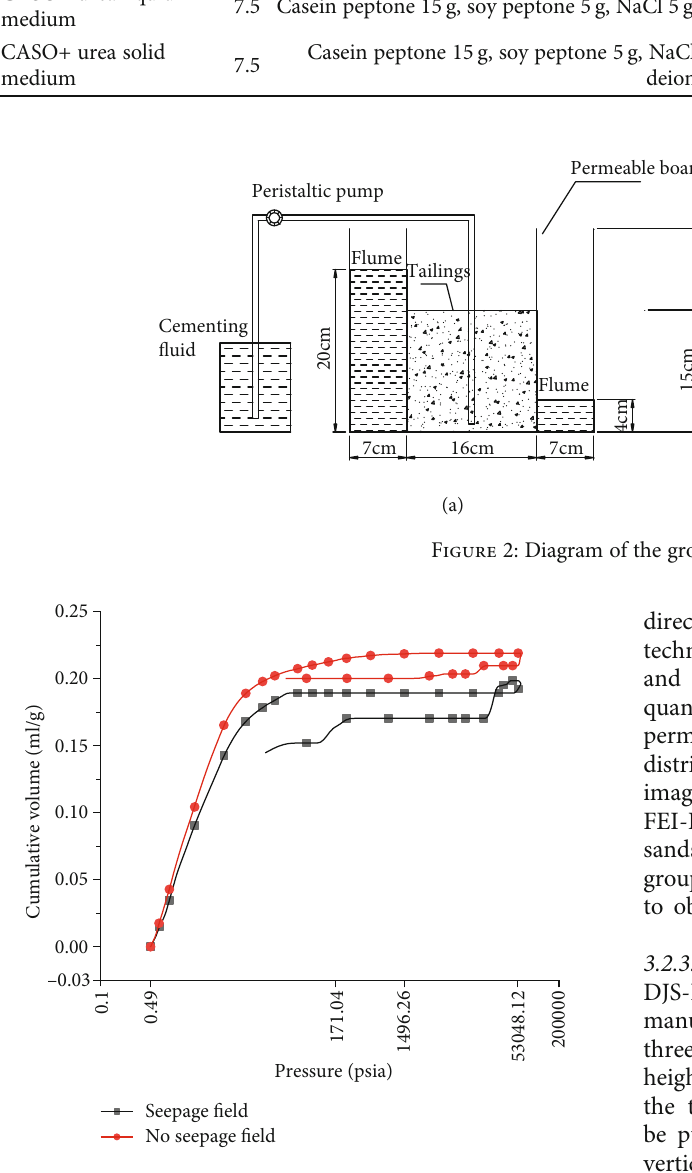
Figure 3: Mercury penetration test